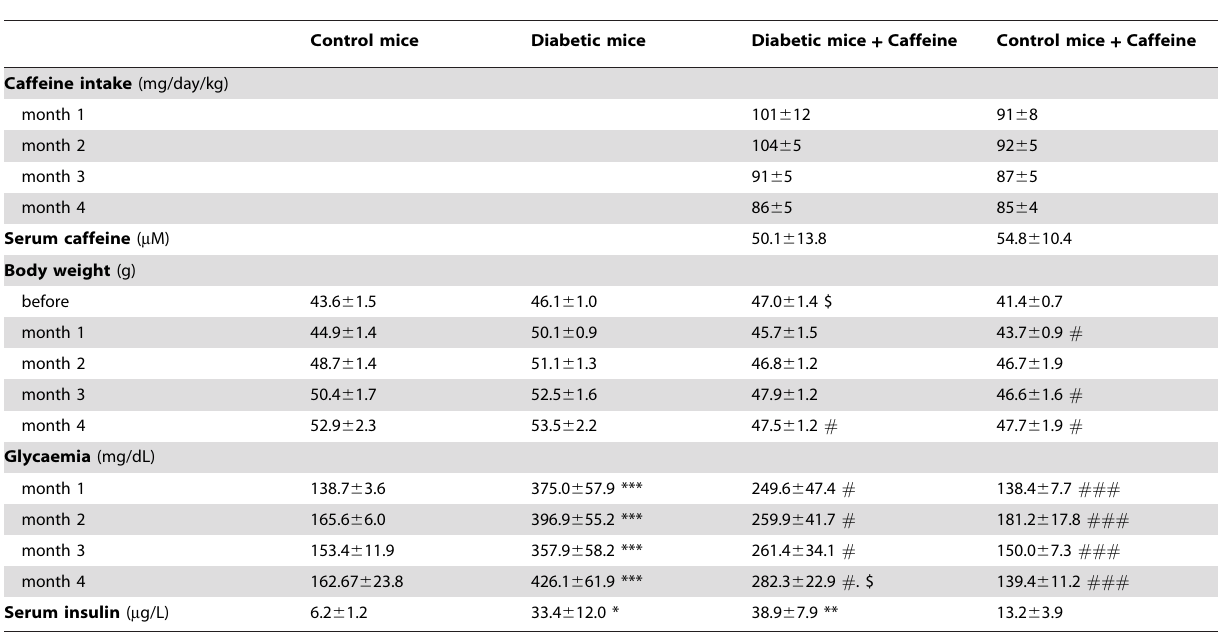
Table 1. Characteristics of the mice involved in the study, during and/or after caffeine treatment.